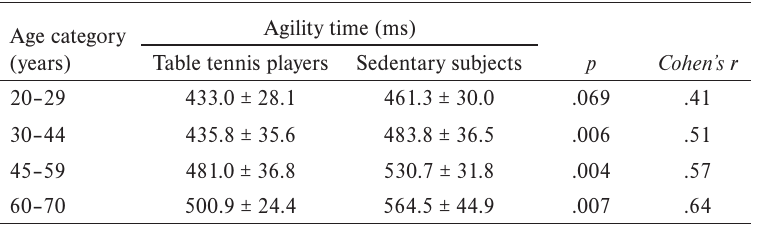
Agility time (mean ± SD) in table tennis players and sedentary subjects of different